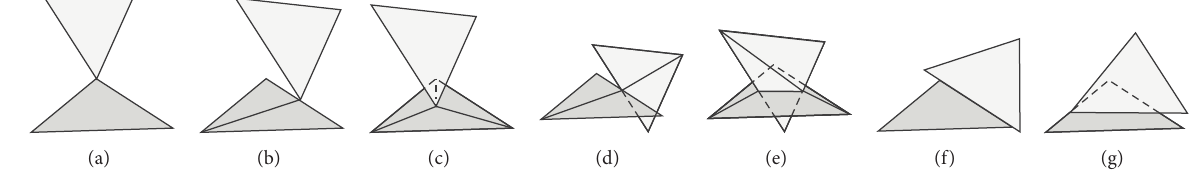
Figure 8: Searching for intersection regions. (a) Coincident nodes intersection. (b) Nodes along edge intersection. (c) Nodes onto face intersection. (d) Edges cutting other edge intersections. (e) Edges cutting face intersection. (f) Edges overlapping other edge intersections. (g) Edges overlapping face intersection.